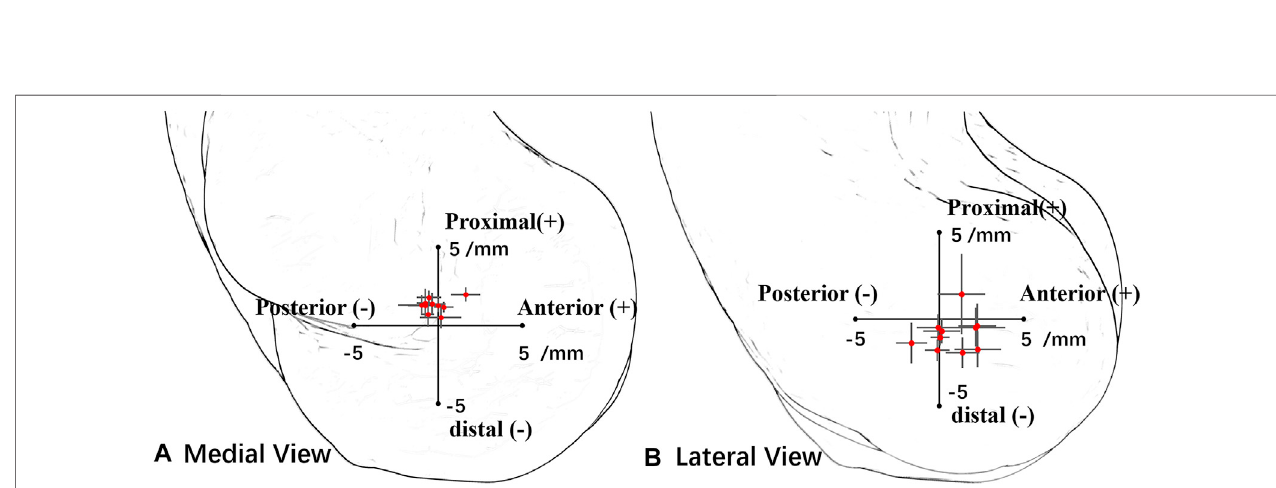
FIGURE 2 | Varus – valgus and internal rotation – external rotation range of the mean fl exion axis (MFA). (A) Varus – valgus (coronal plane view) and (B) internal rotation – external rotation (transverse plane view) of the MFA from all trials of the subject are shown. The solid red line is the mean position of MFA (3.1 ° varus and 1.3 ° internalrotation);theblacklineisthetrochleacentralaxis(TCA).ThelightbluearearepresentsthedeviationofMFAwithinallsubjects(5.4 ° varusmaximumto1.0 ° valgus minimum, and 4.8 ° external rotation to 4.7 ° internal rotation); the models of the humerus are all normalized to the average TCA length of 39.2 mm.